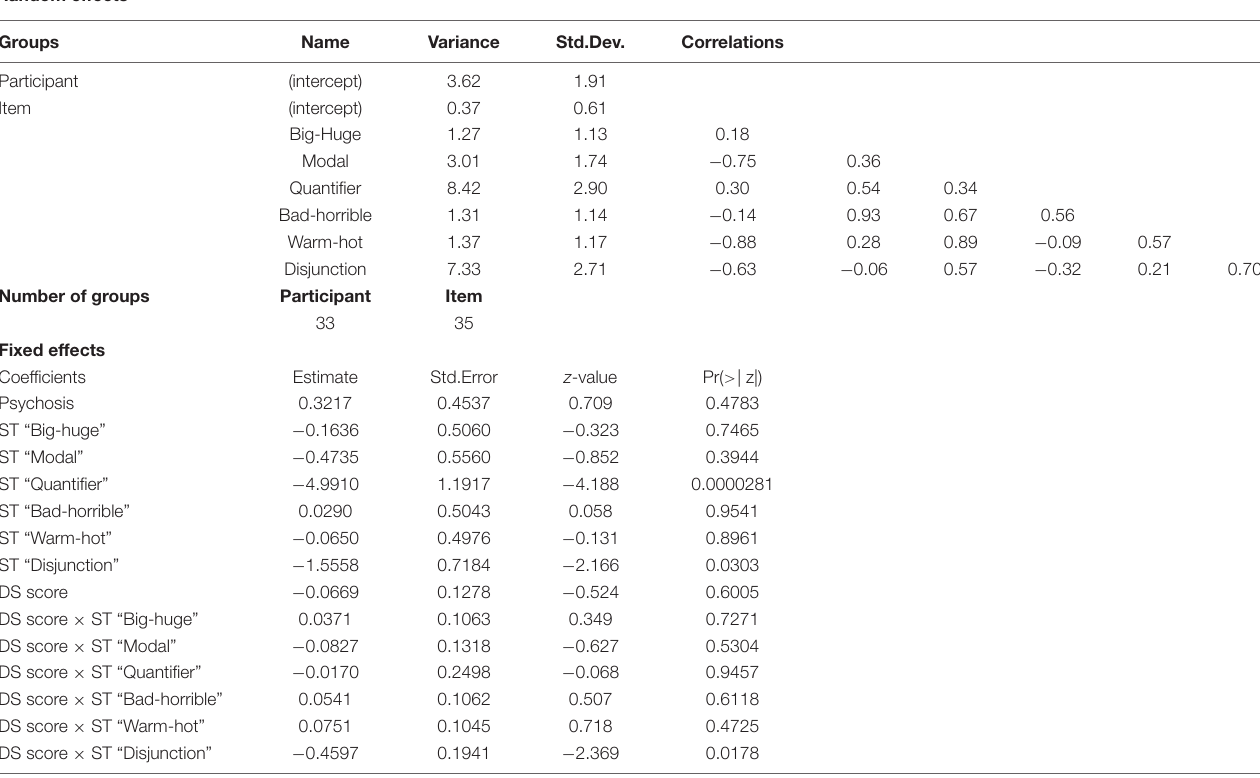
TABLE 3 | Complete description of the final